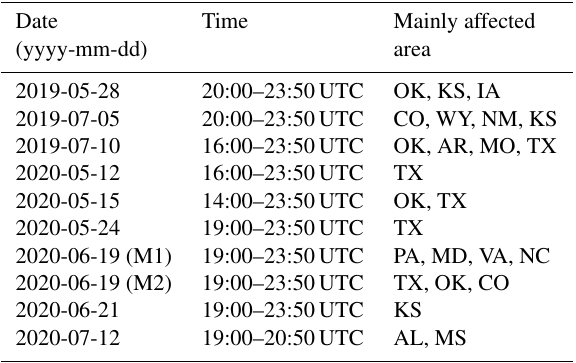
Table 1. A description of 10 convective cases used for training data. M1 and M2 refer to mesoscale sector 1 and 2 domain.